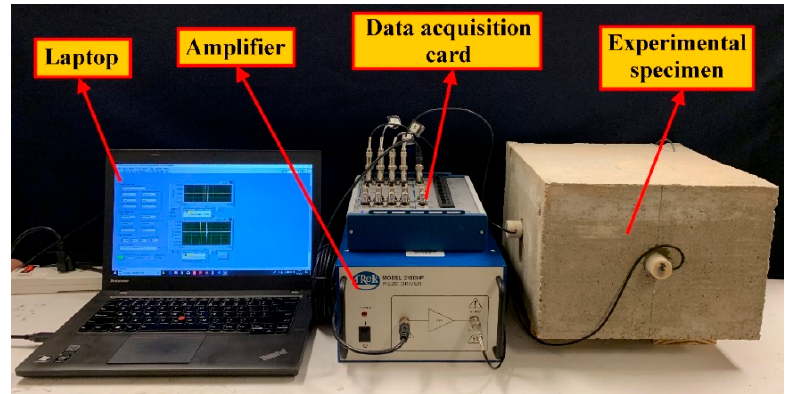
Figure 6. The experimental setup for time of arrival analysis and sweep frequency analysis.